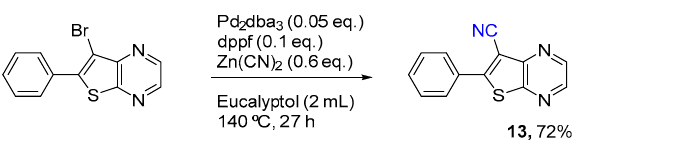
Figure 5. Palladium catalyzed cyanation of 7-bromo-6-phenyl-thieno[2,3- b ]pyrazine. Table 3. Optimization of cyanation.